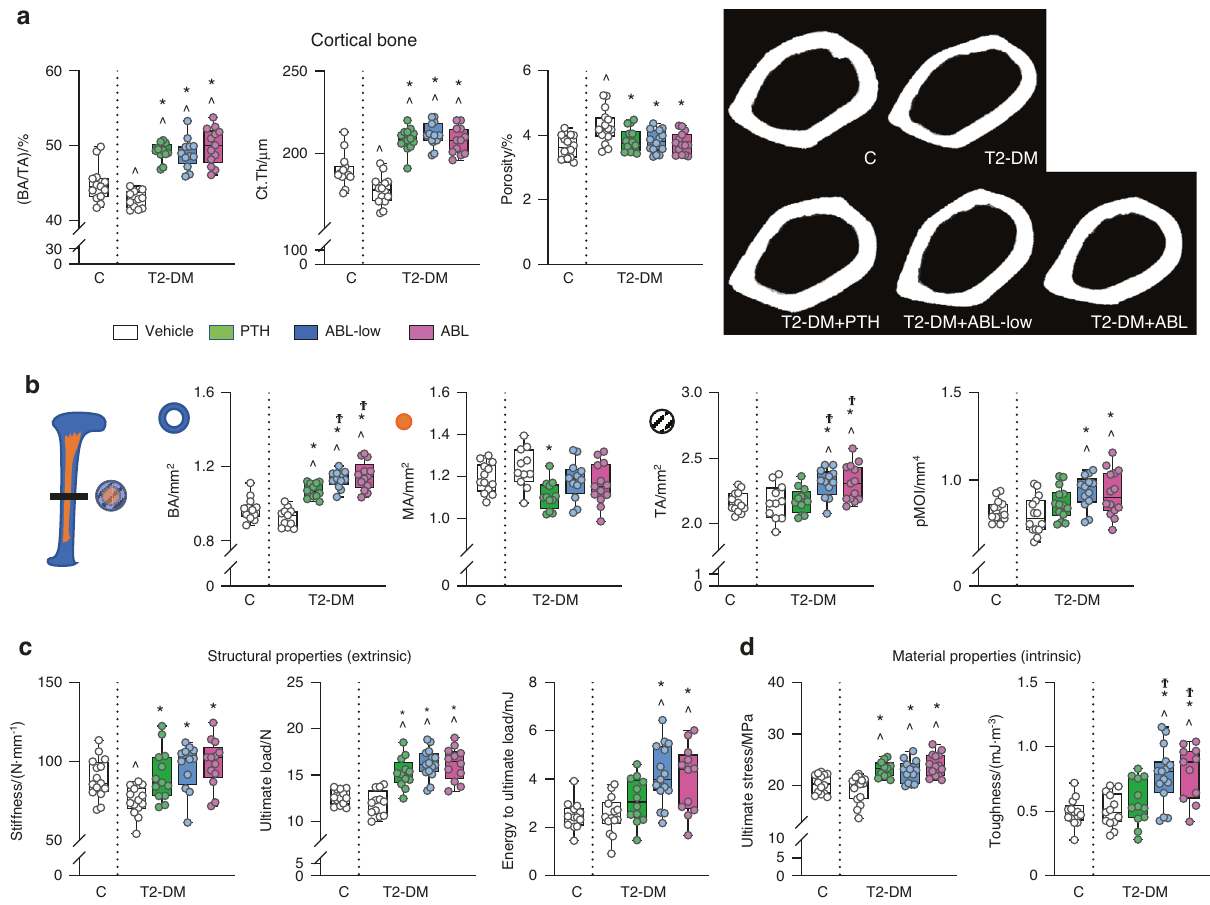
Fig. 2 PTH and ABL corrected the cortical architectural deterioration induced by diabetes and increased bone strength. Micro-CT analysis of femur cortical bone microarchitecture and 3-point bending analysis of bone strength after treatment with PTH or ABL. a Cortical bone area/ tissue area (BA/TA), thickness (Ct.Th) and porosity and representative images. b Bone area (BA), medullary area (MA), total area (TA) and polar moment of inertia (pMOI). c Bone structural properties (stiffness, ultimate load, and energy to ultimate load) and d bone material properties (ultimate stress and toughness). n = 12 – 15 mice per group. Data are presented as box & whisker plot where each dot represents a mouse. ^ P < 0.05 versus C mice by one-way ANOVA with post hoc Dunnet ’ s correction; * P < 0.05 versus T2-DM mice treated with vehicle and Ϯ P < 0.05 versus T2-DM mice treated with PTH by one-way ANOVA with post hoc Tukey ’ s and ABL also increased material toughness above C levels. No (BA/TA) and further increasing these indexes as well as bone area differences in structural or mechanical properties of the vertebral (BA) over C (Fig. 2b). ABL increased bone area even further bone were detected in T2-DM (Table S2). However, PTH increased compared to PTH. In addition, T2-DM increased porosity at the ultimate force, PTH and ABL increased energy to ultimate load, femoral mid-diaphysis and PTH and ABL corrected it (Fig. 2a and and ABL increased energy to yield, over healthy C. Table S1). Restoration of cortical thickness by PTH vs ABL might In summary, PTH and ABL restored and further increased result from bone surface-speci fi c mechanisms, as PTH reduced cancellous and cortical bone volume and improved microarchi- marrow area (MA) whereas ABL increased tissue area (TA). tecture and extrinsic and intrinsic bone properties despite the Consistently, ABL but not PTH increased the polar moment of ongoing hyperglycemic status. inertia (pMOI), resulting from a change in bone geometry leading to increased strength. Further, T2-DM induced marked changes in the geometry of the vertebra (L6), which were overall improved by the anabolic agents (Table S2). Speci fi cally, T2-DM bones exhibited and ABL was more potent decreased vertebral cross-sectional area (CSA) which was corrected Circulating levels of the bone formation marker P1NP were by PTH or ABL treatments. In addition, T2-DM decreased vertebral reduced in T2-DM mice compared to C before treatment at t3 cortical thickness, which was corrected by ABL but not PTH. (Fig. 3a); and PTH and ABL-low were equally potent in increasing T2-DM deteriorated the structural properties of the femur without affecting its material properties, quanti fi ed by three-point bending, and the anabolic agents corrected the structural changes and improved both structural and material properties (Fig. 2c, d and Table S1). Speci fi cally, T2-DM bones exhibited lower stiffness, which was increased by PTH and ABL. The treatments also increased ultimate force and only ABL increased energy to respectively; P < 0.05) (Fig. 3c and Fig. S2b). ABL and PTH were ultimate load. Remarkably, PTH and ABL increased ultimate stress